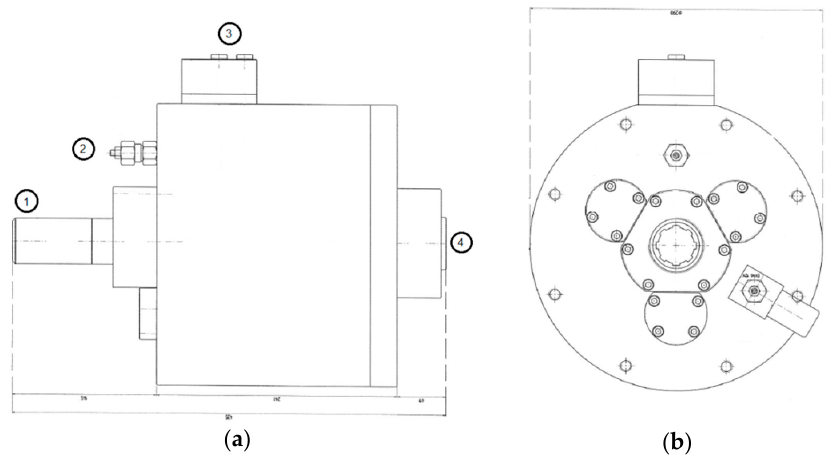
Figure 1. Device scheme: ( a ) Lateral view; ( b ) Frontal view. 1. PTO cardan shaft attachment; 2. main valve; 3. electric control; 4. connection to the wagon.